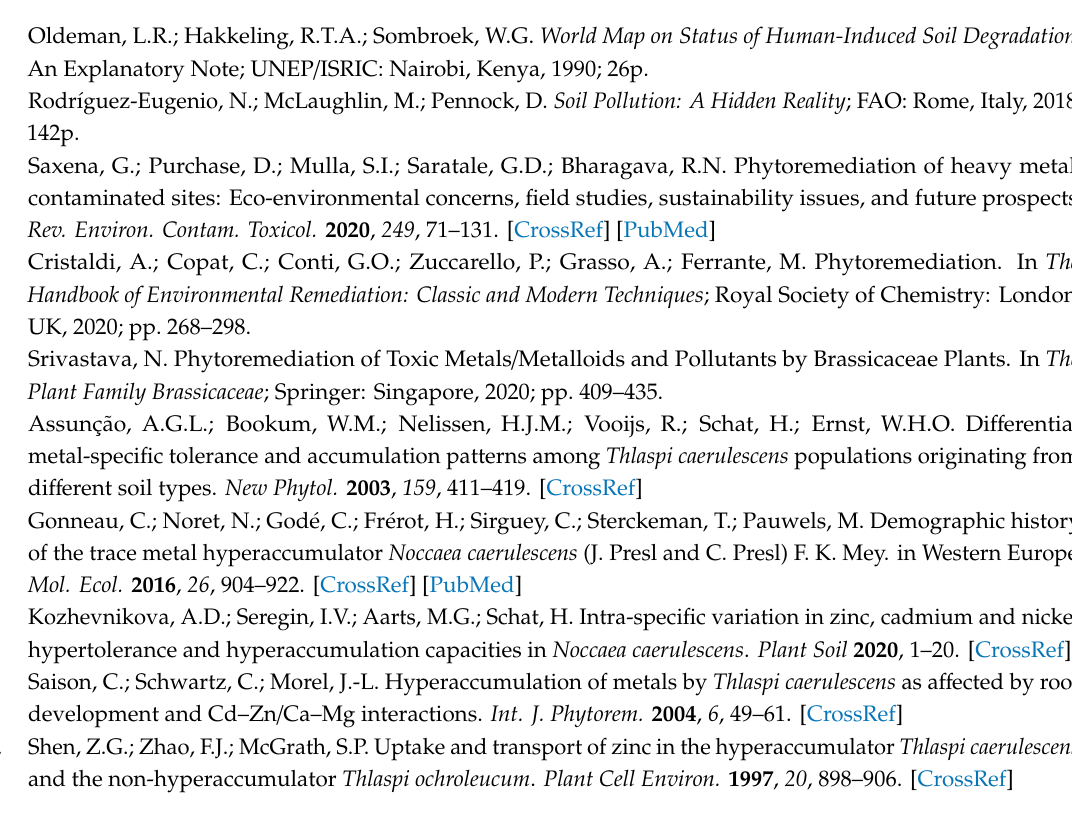
Figure S1: Treatment loadings from the PCAs run with data for each plant species in Experiment 2. Table S1: Results of the PCA run with data for L. albus plants from Experiment 2. Table S2: Results of the PCA run with data for N. caerulescens plants from Experiment